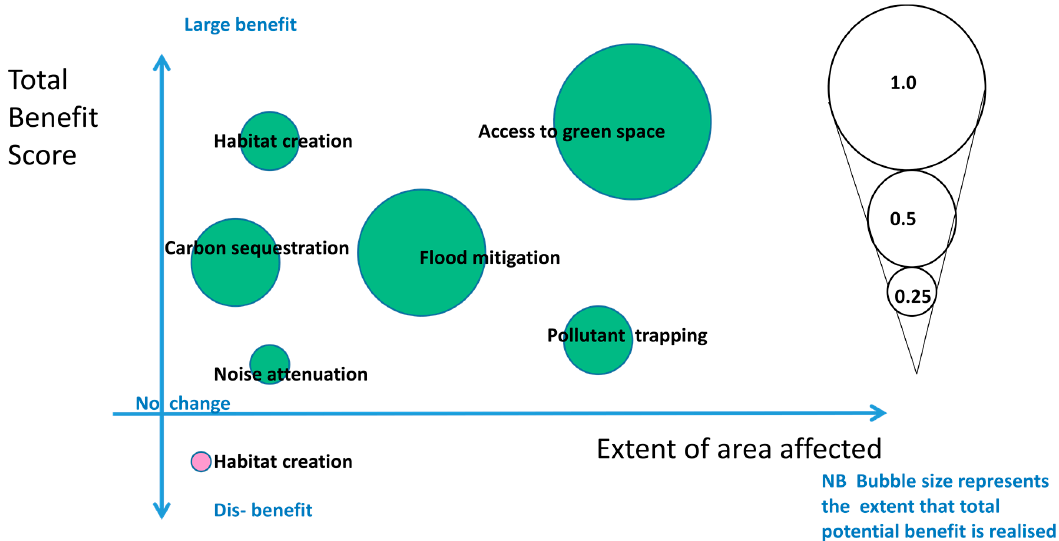
Figure 2. Idealised Benefit profile represented as a bubble chart.